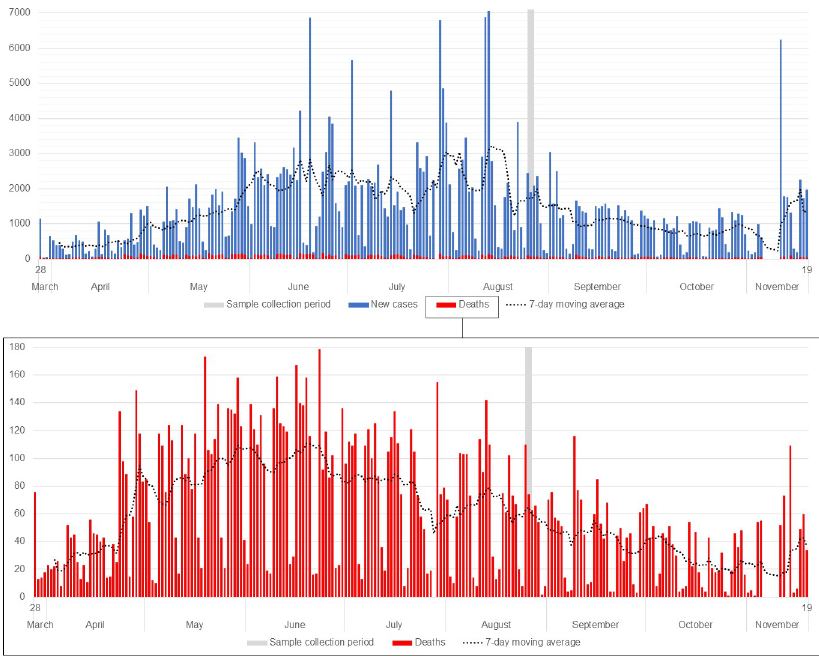
Fig 3. Number of SARS-CoV-2 new cases (upper graph, blue) and deaths (upper and bottom graphs, red) officially reported in S ã o Paulo city, Brazil, from March 28 th (first case of SARS-CoV-2 detected in Brazil) to November 19 th, 2020, with a 7-day moving average. Days of sample collection are shown as grey bars (August 25 th to 27 th , 2020). themselves as Brown (mixed-race Brazilians) (42.9%), followed by white (29.5%), Black (26.1%), and Indigenous Brazilian (1.5%), while the shelter workers were somewhat equally represented by white (35.3%), Black (31.8%), and Brown (32.9%). Finally, 89.7% of the shelter workers had high school and/or higher education diplomas compared with 52.2% of the homeless population. When considering the health histories of both populations, the homeless population was significantly more affected by syphilis and tuberculosis when compared to shelter workers ( p = 0.0009 and p = 0.0002, respectively). Previous or current history of HIV infection, syphilis, hepatitis, and tuberculosis were declared by 6.5%, 15.1%, 8.5%, and 11.4% of the respondent individuals experiencing homelessness, respectively (Table 1). Cardiovascular disease and dia- betes were reported by 29.1% and 9.4% of individuals who are homeless, respectively (Table 1). Overall, the proportions of shelter workers with previous or current infectious diseases were lower, with no reports of tuberculosis and equal percentages of HIV infection, syphilis, and hepatitis, amounting to 2.3% each (Table 2). However, no statistical differences were observed in the proportion of individuals who are homeless and shelter workers affected by HIV or hep- atitis ( p = 0.246 and p = 0.814, respectively). Likewise, cardiovascular disease and diabetes were reported by 25.3% and 6.9% of the shelter workers, respectively (Table 2), with no statisti- cal difference from individuals who are homeless ( p = 0.511 and p = 0.493, respectively). The bivariate analysis for the presence of anti-SARS-CoV-2 IgG antibodies in individuals who are homeless showed statistically significant associations in this population (Table 1), where age (30 to 60 and > 60 years old; p = 0.007 and p < 0.001, respectively) was associated with higher rates of IgG seropositivity, but tobacco use ( p = 0.006), marijuana use ( p = 0.003), and pet ownership ( p = 0.008), including dogs ( p = 0.044) and cats ( p = 0.046) where associated with lower rates of IgG seropositivity (possible protective factors).